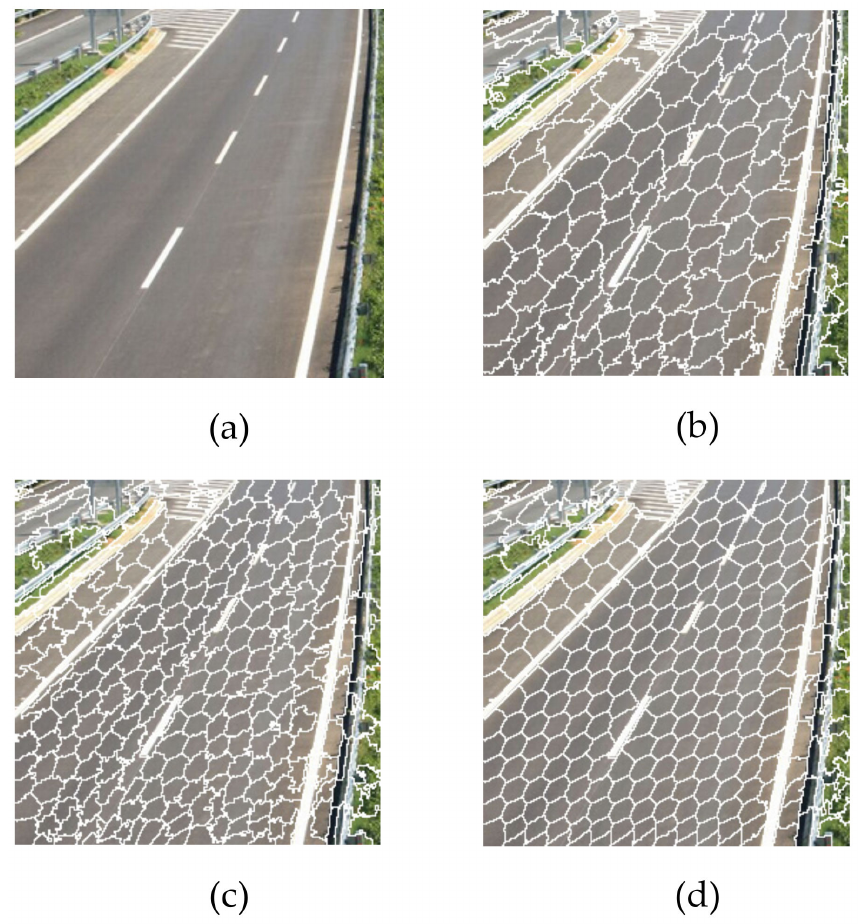
Figure 2. Simple linear iterative clustering (SLIC) parameter setting effect: ( a ) original road image;